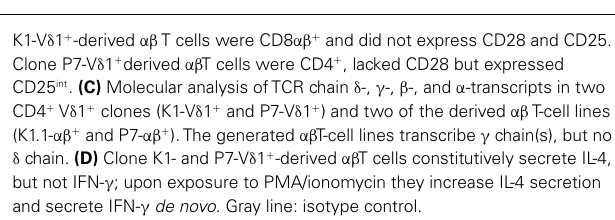
FIGURE 5 | Continued Phenotypic, molecular, and functional characterization of αβ T cell lines exemplarily shown for lines derived from two different clones. (A) Process of transdifferentiation in a CD4 + V δ 1 + clone. Change ofTCR expression (top), and change of co-receptor expression (bottom). (B) Resulting αβ T-cell populations were heterogeneous. Exemplarily shown are twoT-cell lines derived from two different clones.TheirT-cell lines were terminally differentiated CD45RA-re-expressingT effector-memory cells (TEMRA). Clone